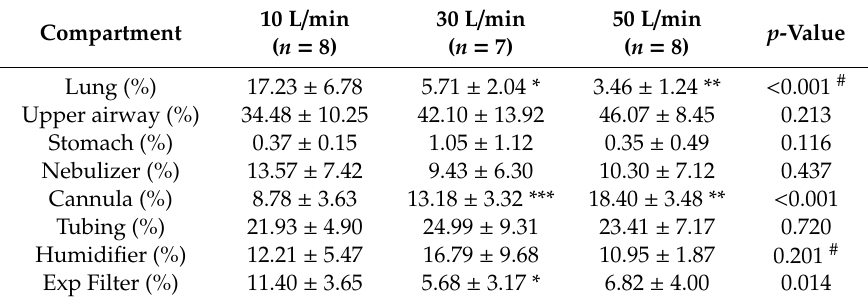
Table 2. Percentage of mass aerosol deposition across compartments with di ff erent flow rates using the heated / humidified HFNC